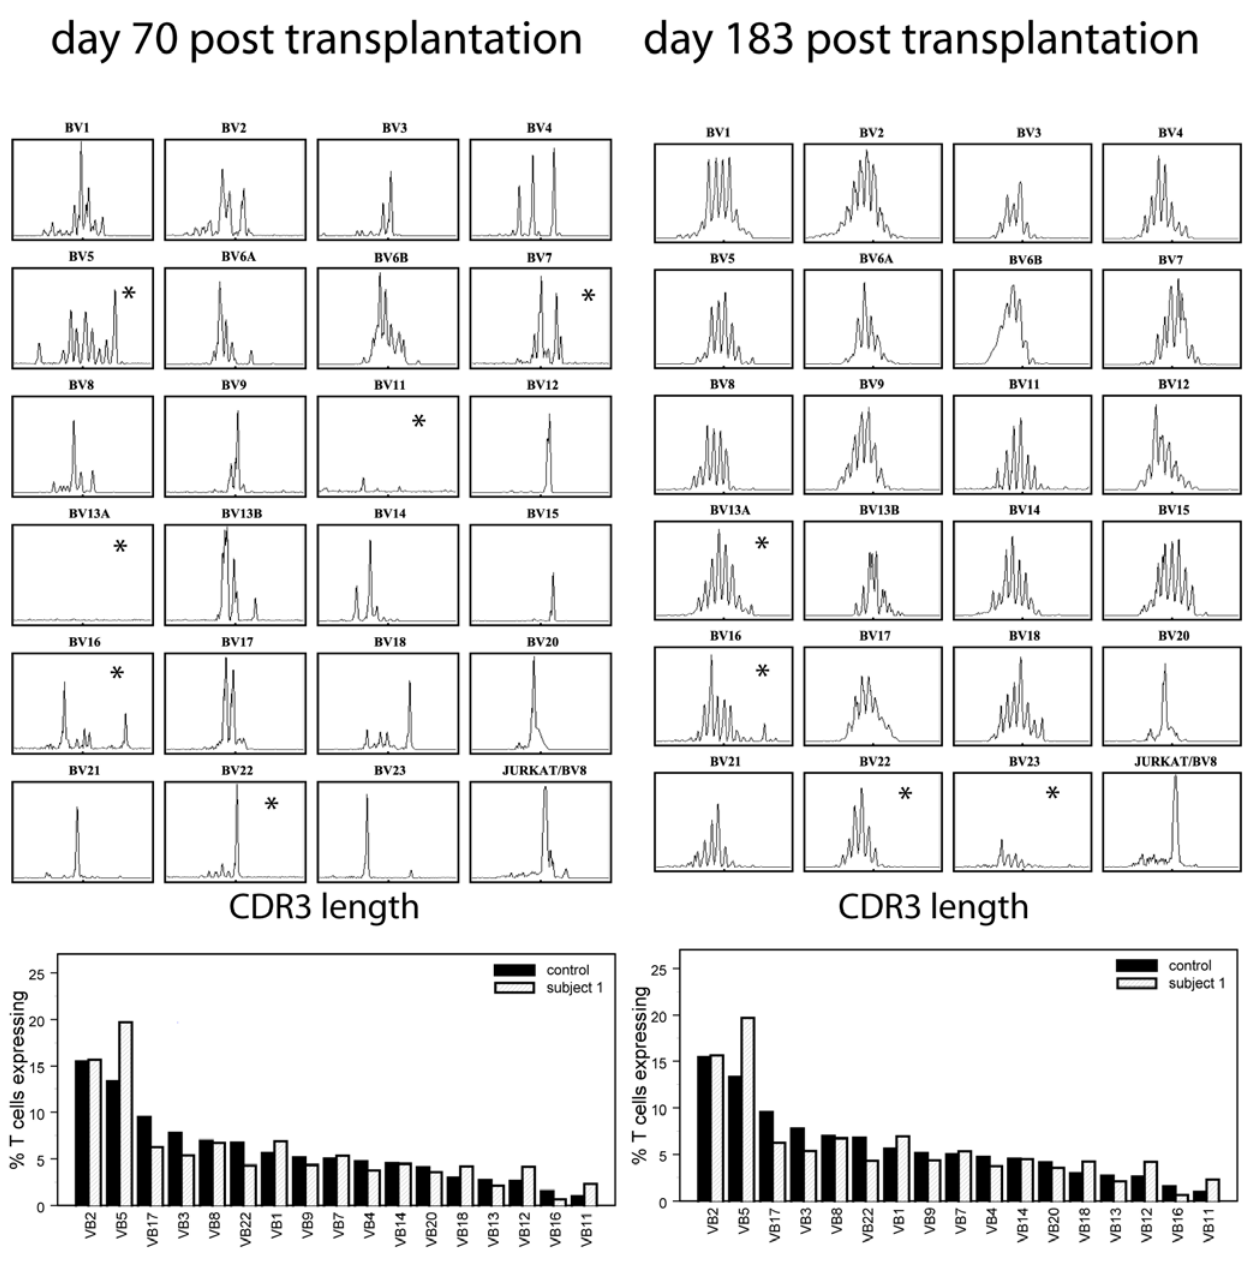
Figure 2. Spectratype data. Raw CD4 + spectratype data (upper panel) for subject 1 on days 70 (left) and 183 (right) post-transplantation. CD4 + TCRBV usage frequency for average over 10 healthy controls (solid bars), and subject 1 (striped bars) on the same two days. The raw spectratype profiles are not represented on a consistent scale. Assays that had no peaks above 500 fluorescent units are routinely excluded from subsequent analysis. These are marked with an asterisk.